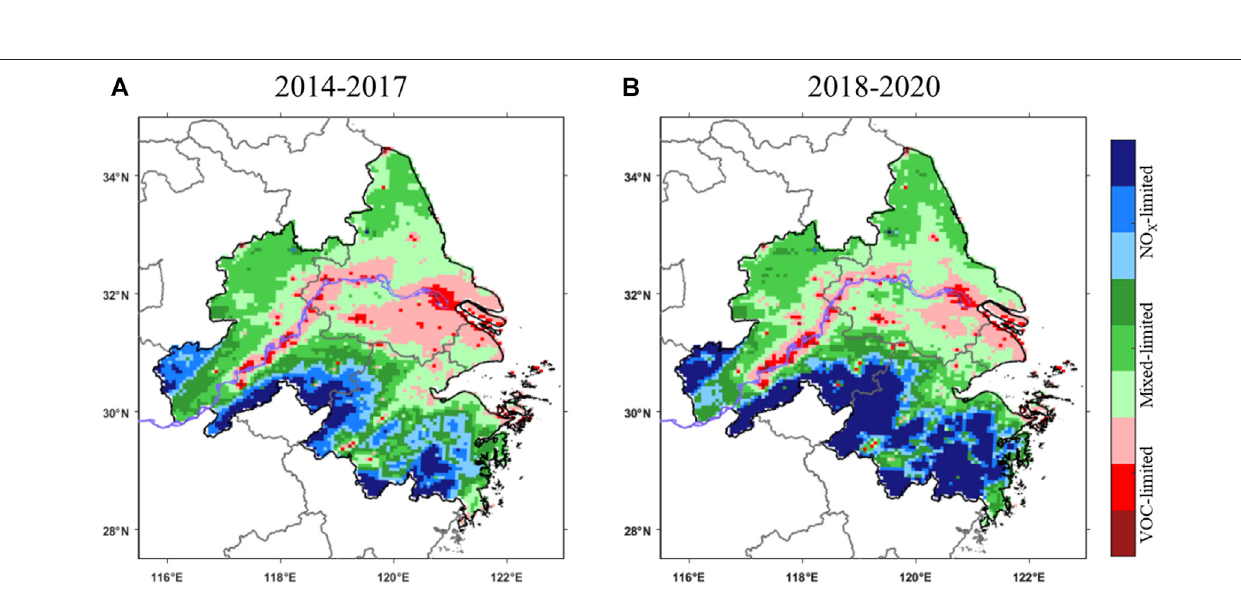
Frontiers in Environmental Science |